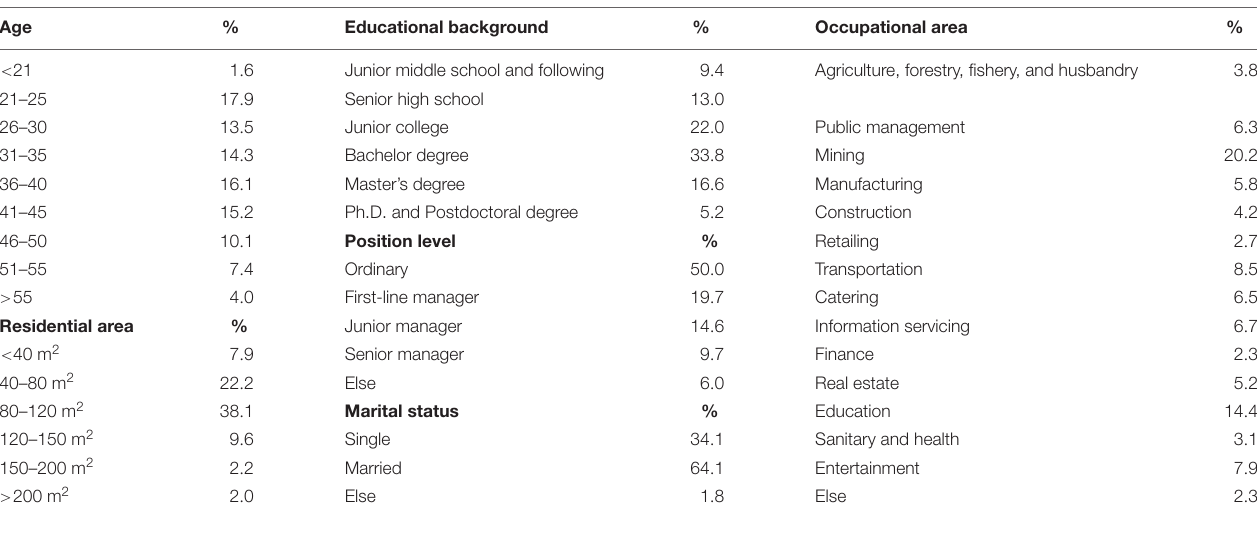
TABLE 2 | The structure of